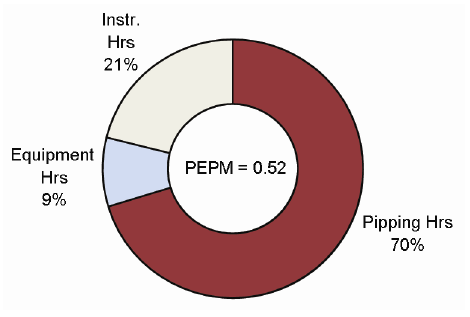
Fig. 7. Work-hour percentage of the sample